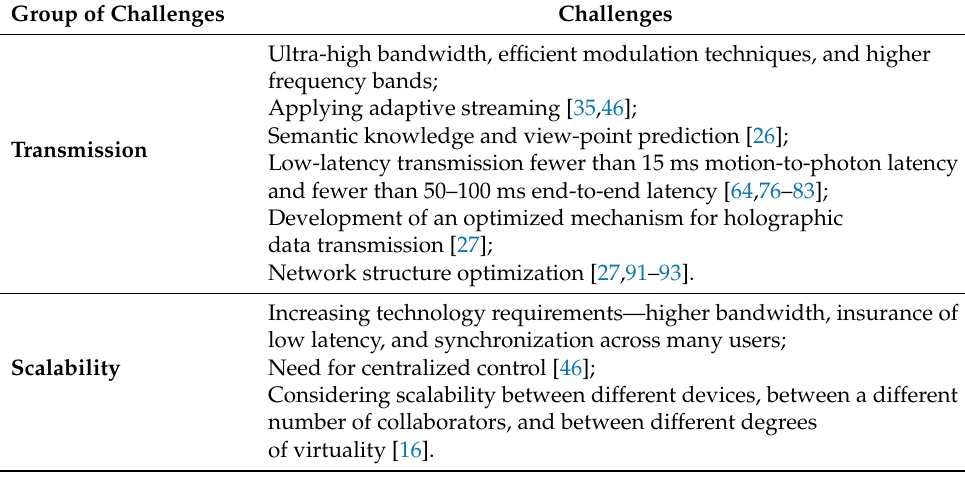
Table 3. Cont . Group of Challenges